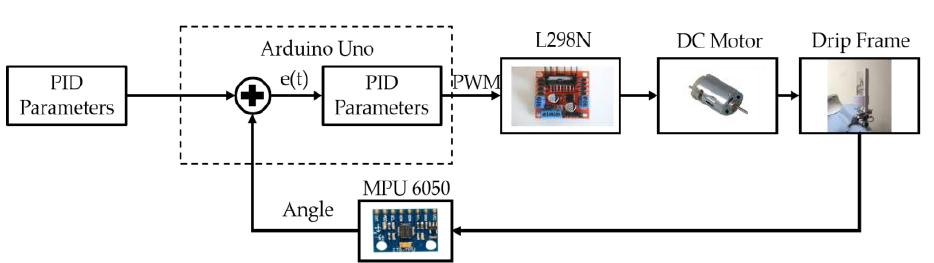
Figure 21. Closed-loop DC motor speed control scheme on PID controller.